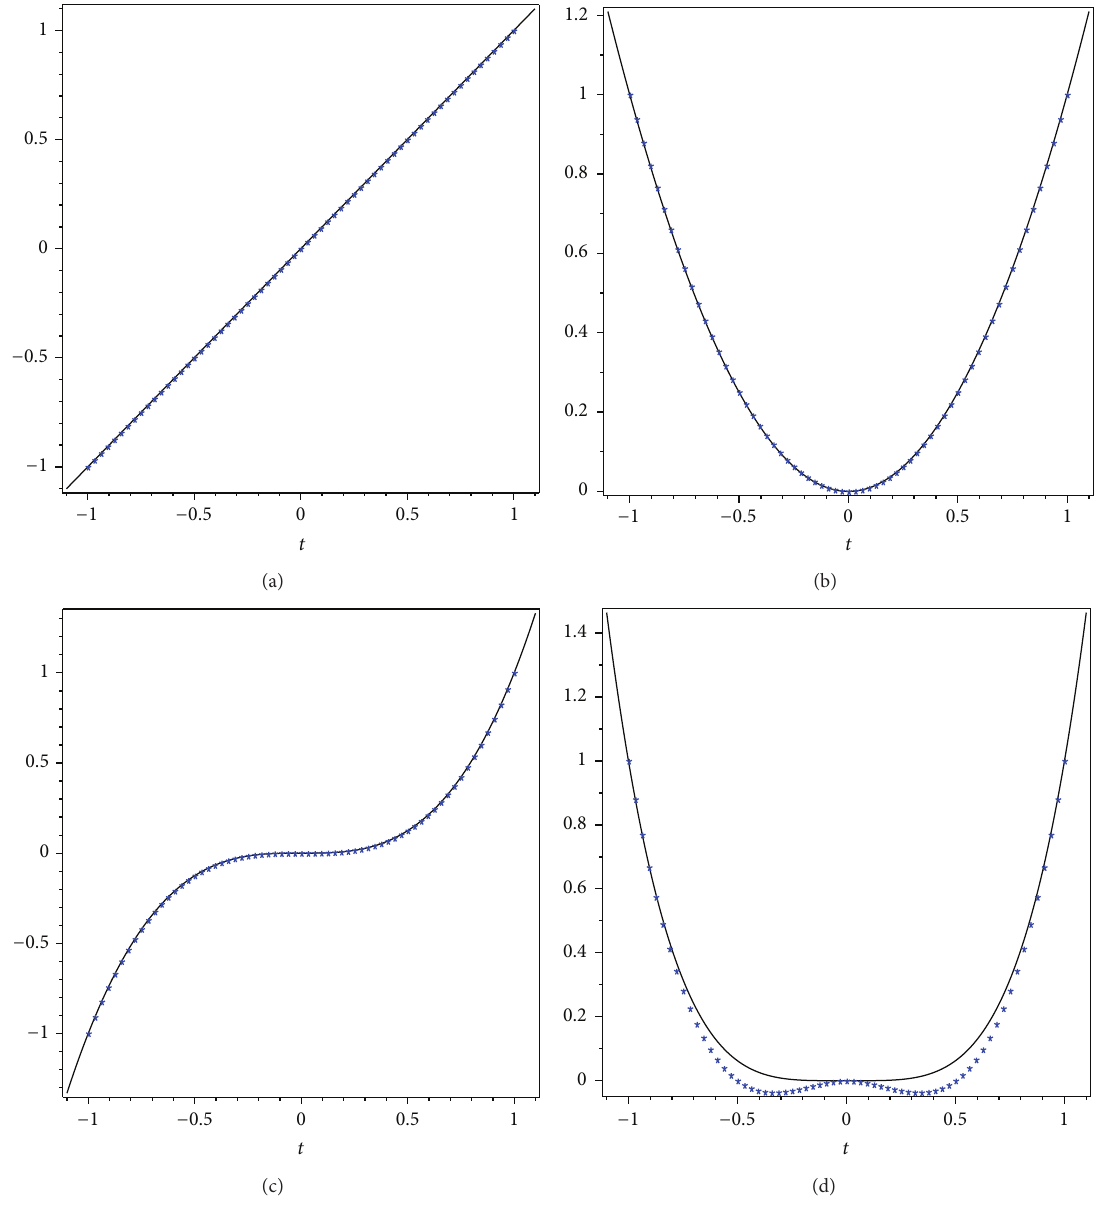
Figure 3: Polynomial reproduction of scheme S ̃𝑃,̃ h with scheme mask symbol (68); solid line denotes the true polynomial and asterisk 0 ,̃Φ 0 point denotes the discrete data using 5 times iteration of subdivision operator; (a) 𝑝(𝑡) = 𝑡 ; (b) 𝑝(𝑡) = 𝑡 2 ; (c) 𝑝(𝑡) = 𝑡 3 ; (d) 𝑝(𝑡) = 𝑡 4 .